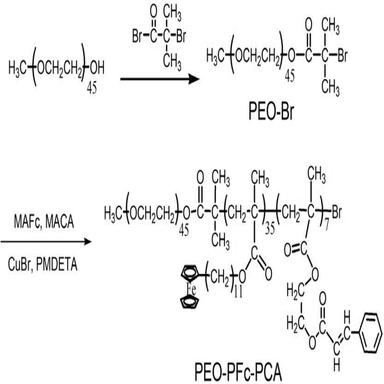
Synthetic pathway for the block copolymer PEO-PFc-PCA.